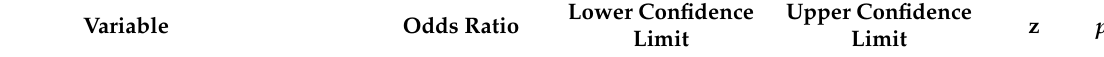
Table 7. Multivariable models of decreased walk frequency and duration during lockdown, compared with